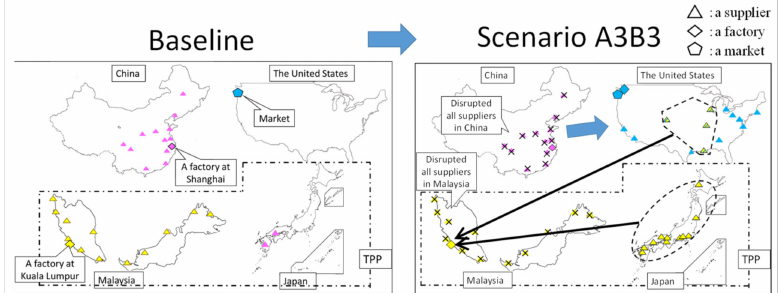
Figure 7. The result of the redesigned global supply chain network from baseline to scenario A3B3. Map Source: https://www.freemap.jp/ (accessed on 30 November